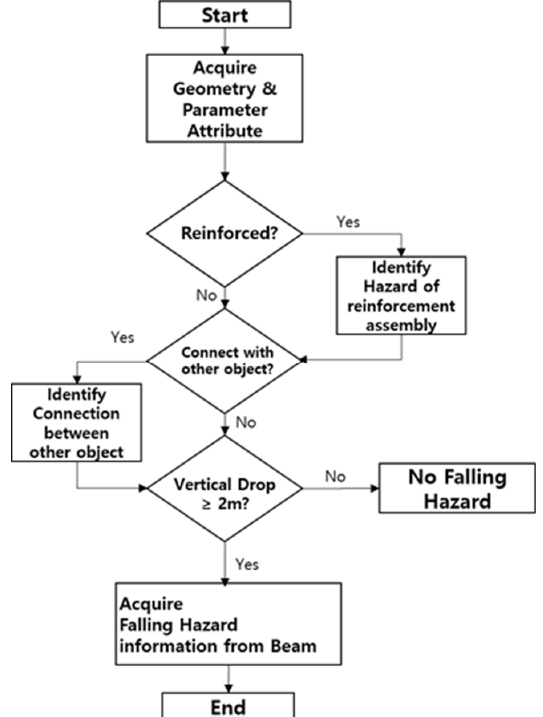
Figure 4. Algorithm of hazard derivation from BIM model. 2